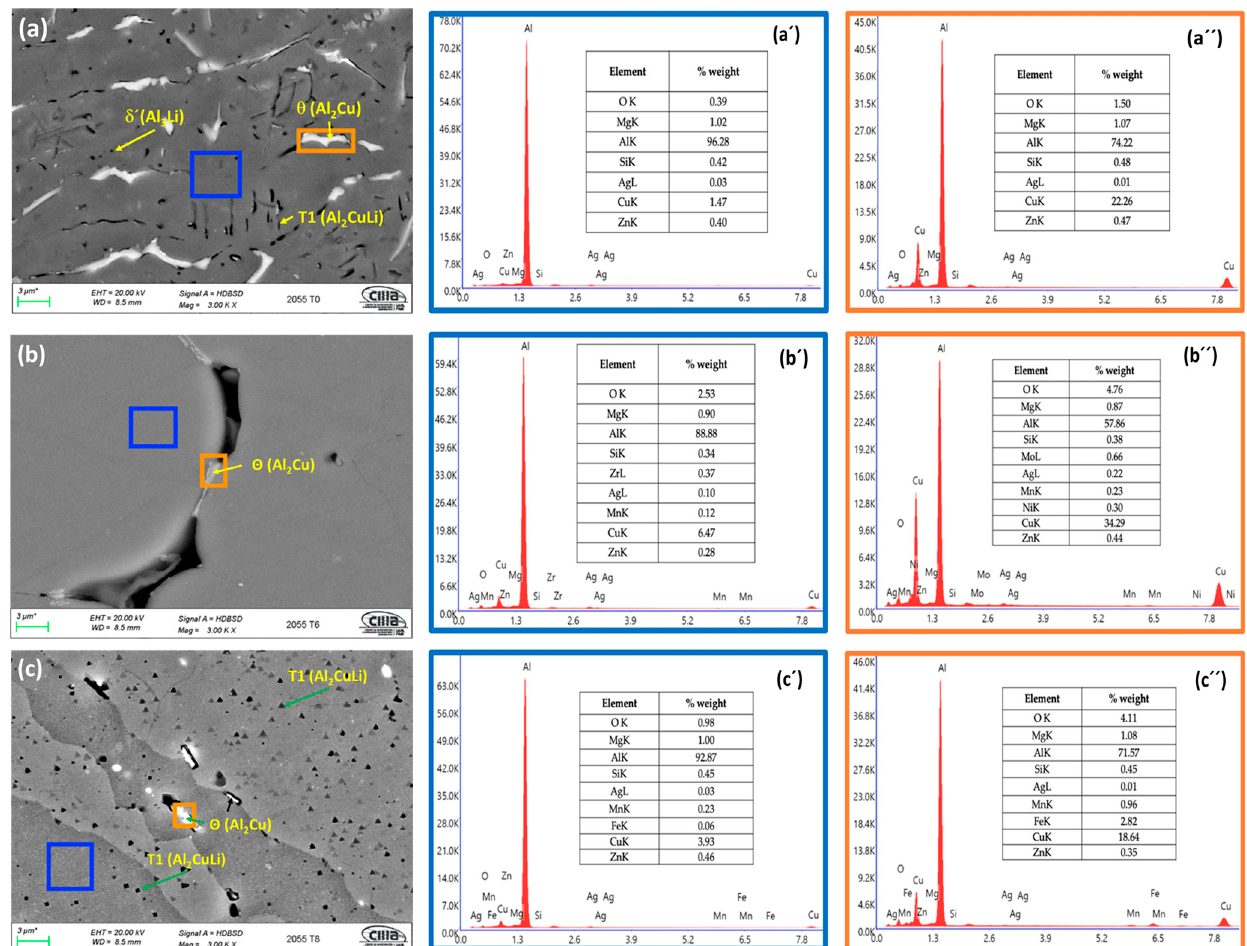
Figure 5. SEM-BSE micrographs of AA2055 alloy under ( a ) T0, ( b ) T6 and ( c ) T8 heat treatment conditions and EDS spectrum [T0 (a’, a’’), T6 (b’, b’’) and T8 (c’, c’’)].